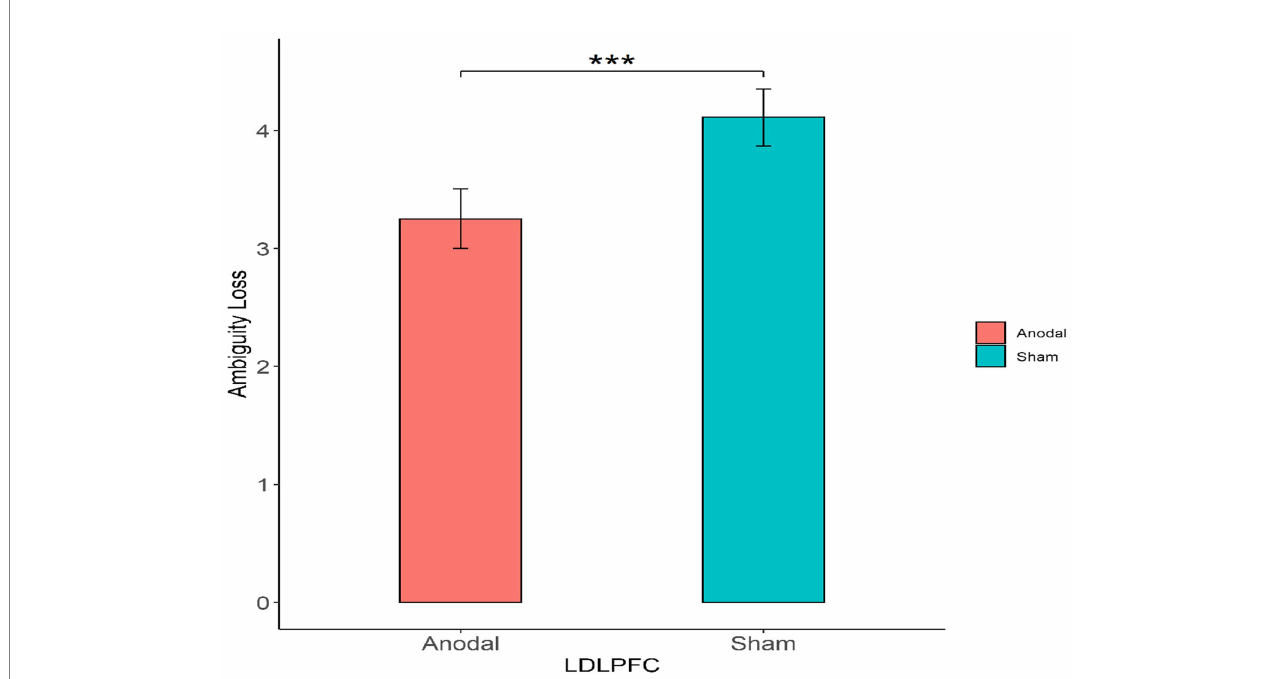
FIGURE 4 The degree of the participants’ attitudes toward ambiguity loss under different left DLPFC stimulation conditions. Error bars represent standard errors. Asterisks indicate statistically significant difference between the stimulation types.